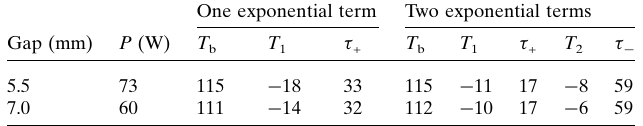
Table 2 The fitted parameter for the single- and double-exponential models, using data in Fig. 7.